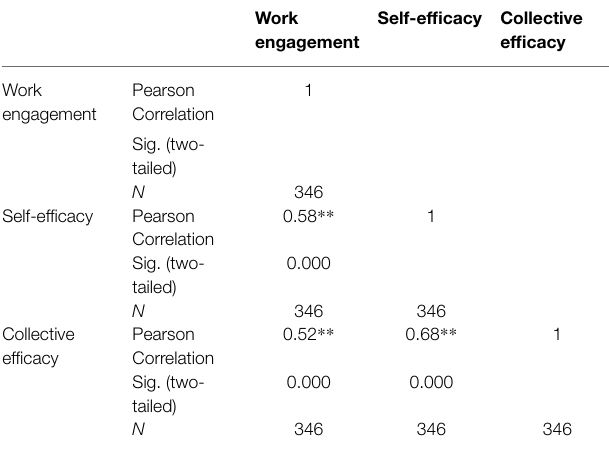
TABLE 5 | Results of Pearson Correlation between overall EFL teachers’ self- efficacy, collective efficacy, and their work engagement.